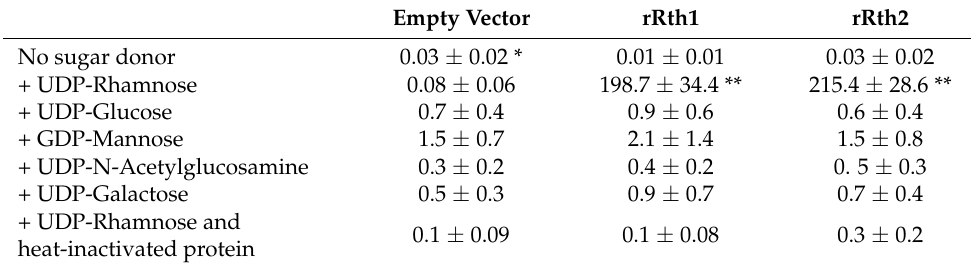
Table 3. Enzyme activity of recombinant Rht1 and Rht2 using different sugar